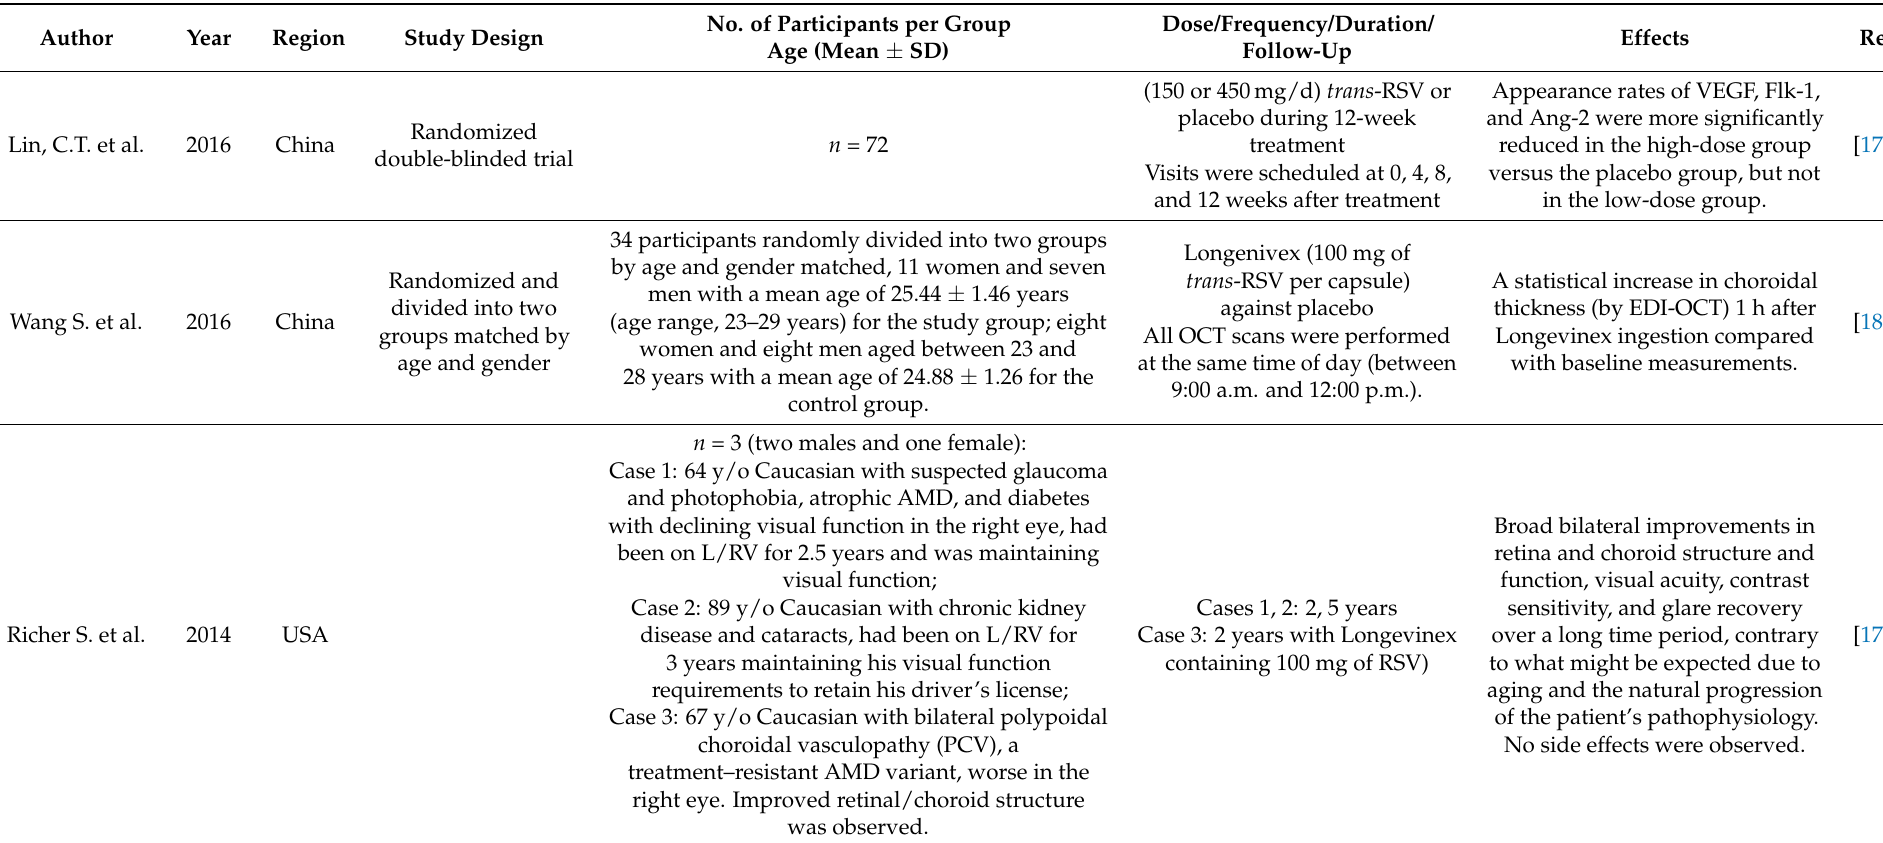
Table 2. Clinical trials with resveratrol with ocular